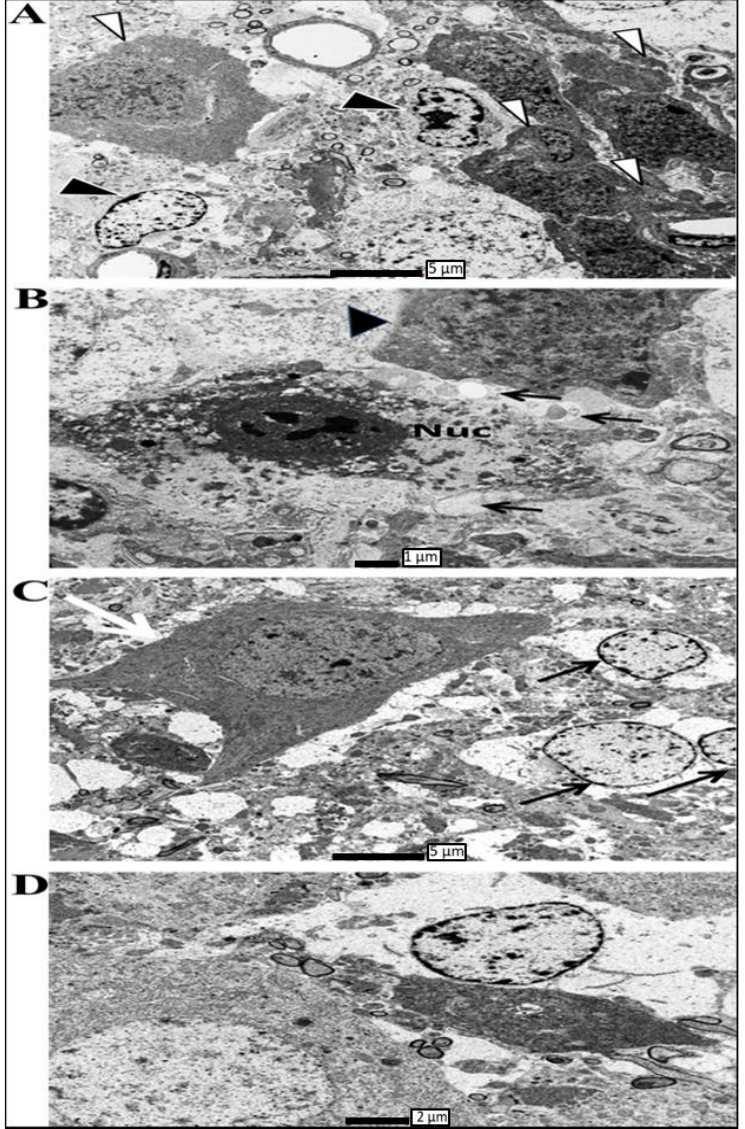
Figure 7. Electron micrographs showing degeneration in different areas of the hippocampus of ADX rats, compared to the SHAM operated, were taken 14 days postoperatively. ( A ) Electron micrographs taken from the upper blade of the dentate gyrus 14 days following adrenalectomy showing granule cell engulfed by microglia (white arrows); in addition, it shows other granule cells undergoing degeneration where fragmentation of the nucleus and vacuolation in the cytoplasm is very apparent (black arrow). Scale bar = 5 µ m. ( B ) High power microscopy of degenerated granule cells in the hippocampus of adrenalectomized rats 14 days following adrenalectomy. Appearance of vacuolation in the cytoplasm with condensed chromatin (thin arrow) and adjacent granule cell in the process to be engulfed by microglia (big arrow). Scale bar = 1 µ m. ( C ) High power microscopy taken from CA4 area of the hippocampus following 14 days of adrenalectomy showing many empty spaces in the pyramidal layer. In addition, many neurons with compacted chromatin surrounded by irregular nuclear membrane black arrow. A glial cell in the process to phagocyte pyramidal cell of the CA4 white arrow. Scale bar = 5 µ m. ( D ) Electron micrograph showing CA3 pyramidal cells at different stages of degeneration 14 days following adrenalectomy, confirming that withdrawal of glucocorticoids by adrenalectomy is not selective where different neuronal populations in the hippocampus are subjected to substantial degeneration. Scale bar = 2 µ m. Three independent sections per brain were examined ( n = 3 in each